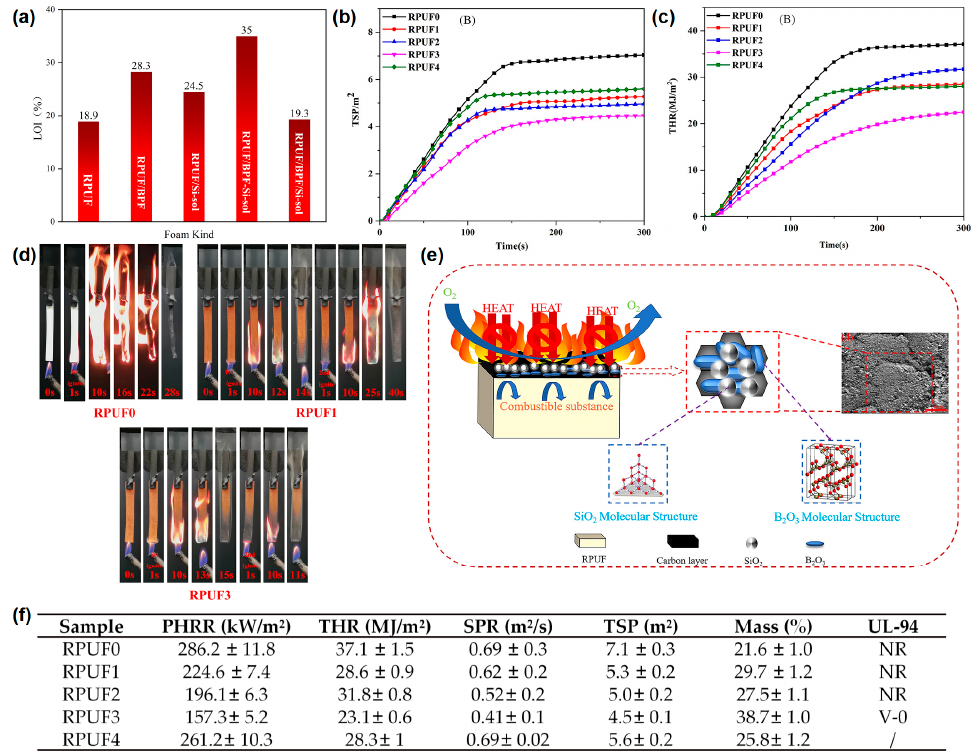
Figure 3. ( a ) The histogram of LOI values of pure RPUF and treated RPUF samples, ( b ) THR, and ( c ) TSP curves of pure RPUF and treated RPUF samples; ( d ) video screenshot of pure RPUF, RPUF coated with BPR, and RPUF coated with BPR/Si-sol during UL-94 test; ( e ) schematic diagram of the flame-retardant mechanism of treated RPUF samples; ( f ) the data of p-HRR, THR, SPR, TSP, residual mass in cone test, and UL-94 test of pure RPUF and treated RPUF samples [31].